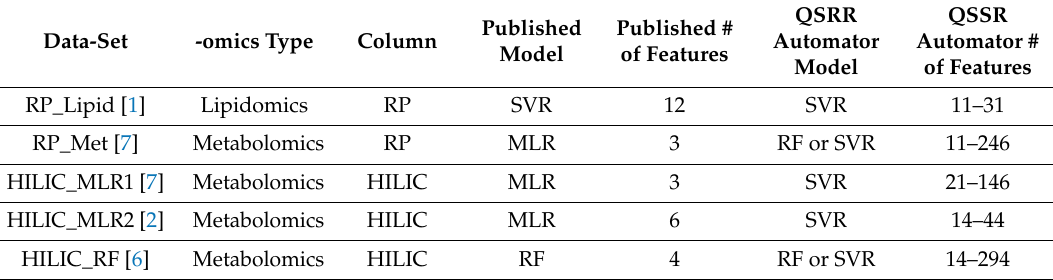
Table 1. Comparison to published data-sets. This table provides details on the various data-sets used and how the QSRR Automator models compare. Data-Set provides an abbreviated name, -omics type is whether the compounds are from a lipidomics or metabolomics study, Column is whether a reverse phase (RP) or Hydrophilic Interaction Chromatography (HILIC). Published Model and QSRR Automator Model is the machine learning model used in each analysis, and Published # of Features and QSRR Automator # of Features are how many molecular descriptors were used in the appropriate final